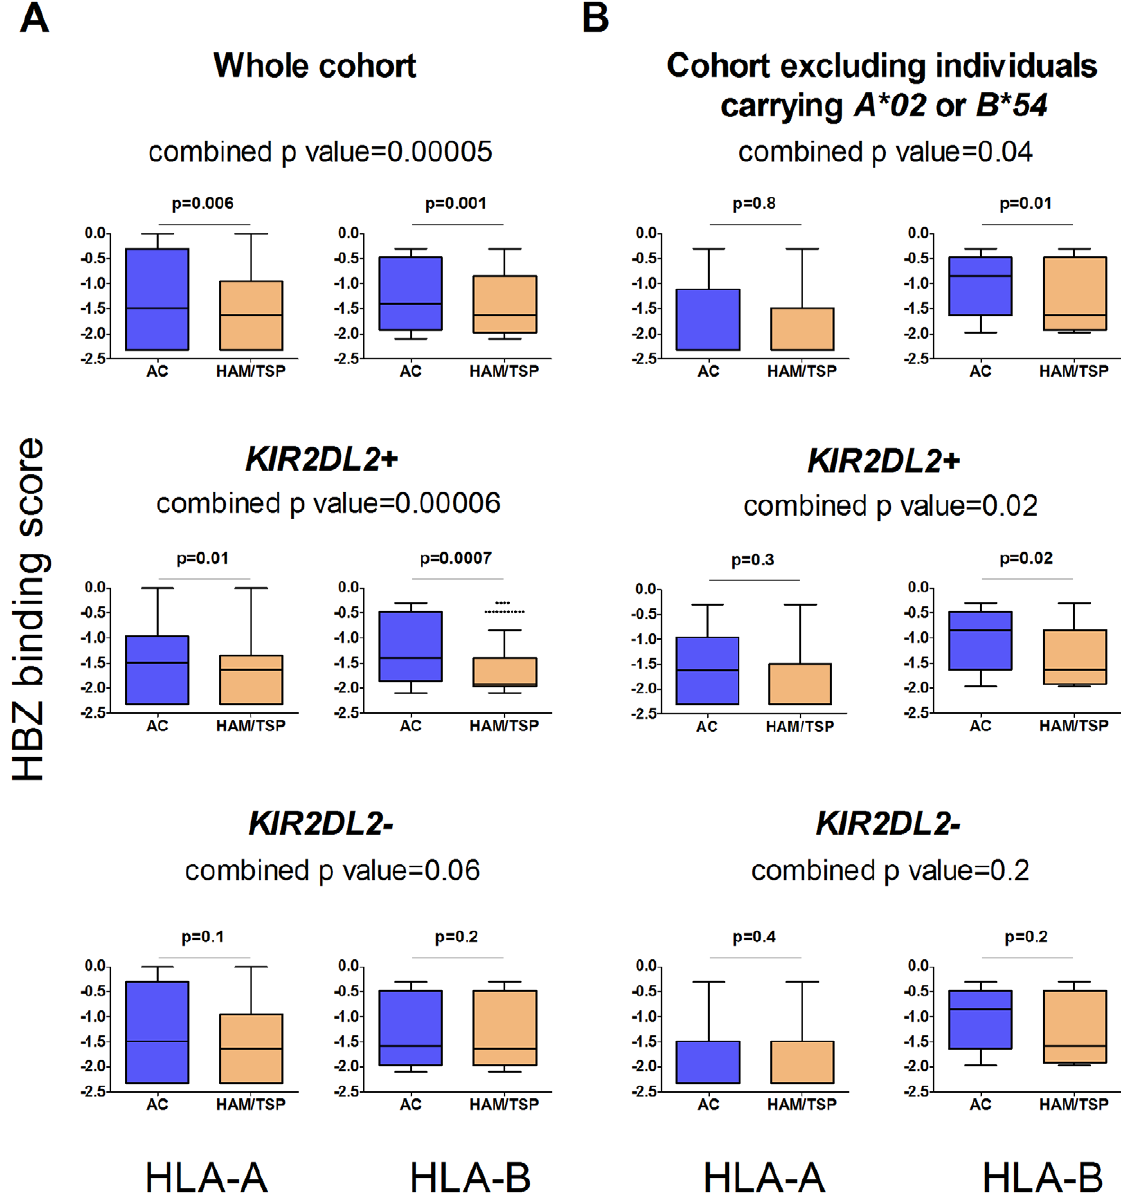
Figure 2. The protective effect of binding HBZ is enhanced by KIR2DL2 . In the whole cohort ( Figure 2a ) individuals with HLA-A or B molecules which were predicted to bind peptides from HBZ strongly were significantly more likely to be asymptomatic (top row); this effect was stronger in the individuals with KIR2DL2 (middle row) than without (bottom row). When individuals with A*02 or B*54 were removed ( Figure 2b ) the pattern remained the same. This indicates that the protective effect of binding HBZ peptides by multiple, different HLA class I molecules, both A and B, is enhanced by KIR2DL2.We did not predict HLA-C binding as the relevant algorithms are not available in Metaserver (due to scarcity of HLA C binding data necessary for training the neural networks).